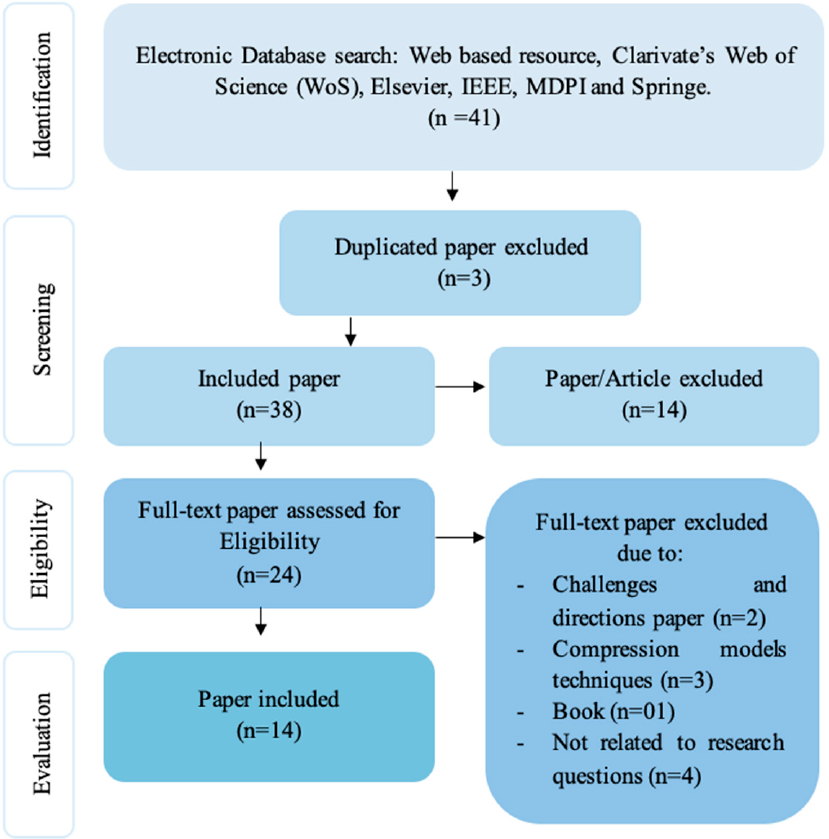
Figure 3. PRISMA flowchart for the study.